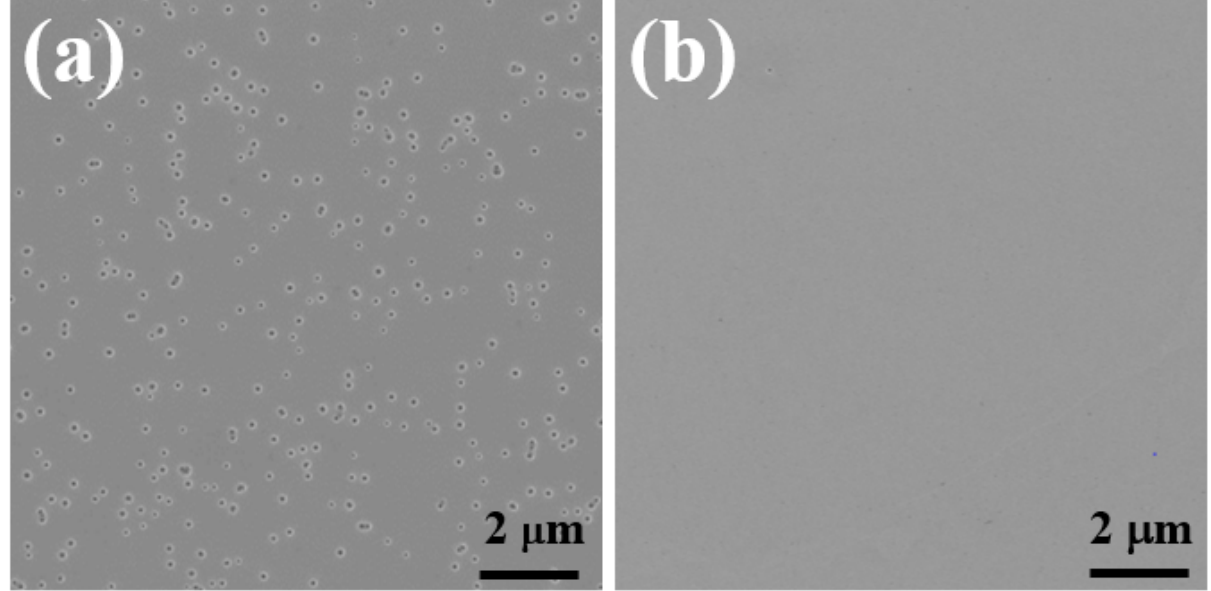
Figure 1. Plan ‐ view SEM images of ( a ) sample A and ( b ) sample B prior to EC etching. Figure 1. Plan-view SEM images of ( a ) sample A and ( b ) sample B prior to EC